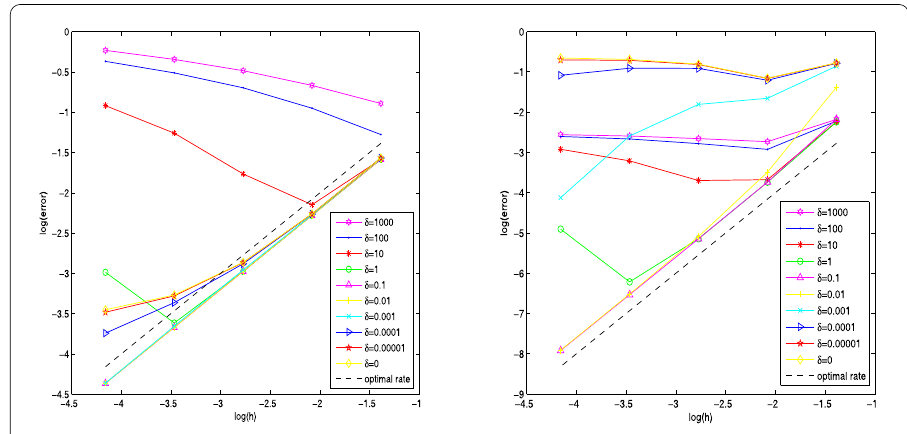
Figure 2 The order of convergence for the different values of the stabilization parameter δ for test 1. (Left) The order of the convergence of (cid:10) u h